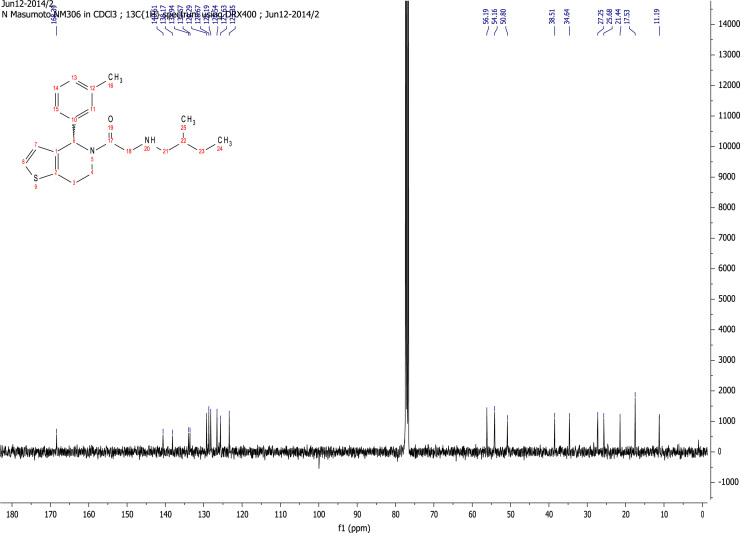
13C NMR (101 MHz, CDCl3) of RU-SKI 101
(9c).